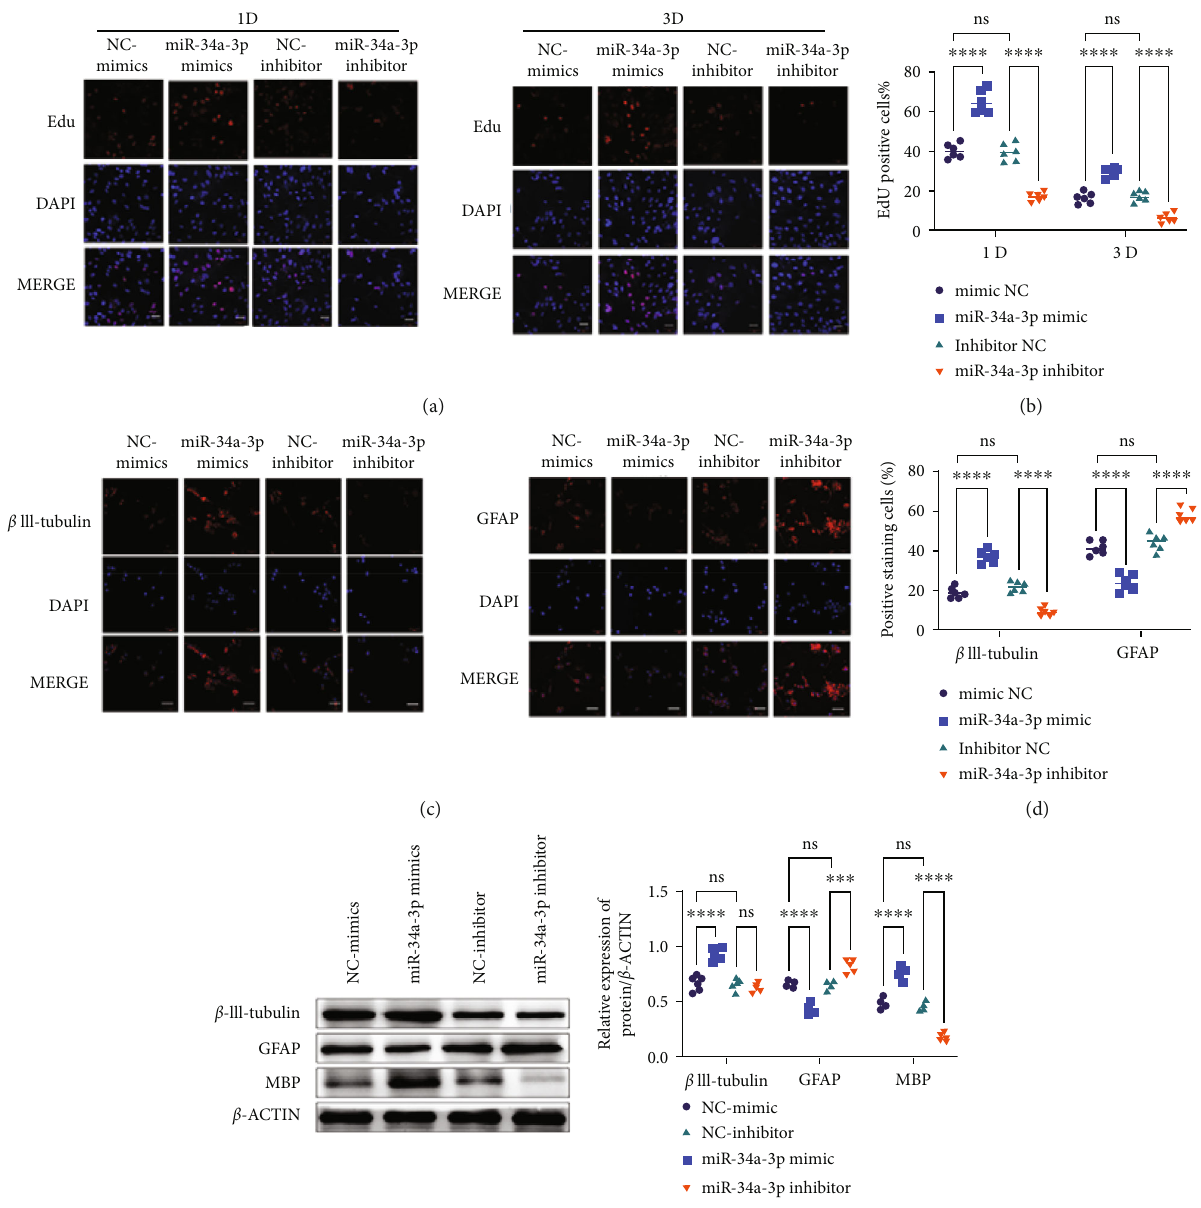
Figure 2: miR-34a-3p facilitates in vitro NSC proliferation/neuronal di ff erentiation. (a) EdU cell proliferation assay of NSCs at di ff erent time points after treatment with miR-34a-3p mimic or inhibitor. Representative images of six ( n = 6 ) independent experiments are presented. (b) Quanti fi cation of EdU-positive NSCs. (c) Immuno fl uorescence analysis of β III-tubulin and GFAP in di ff erent treatment groups. Representative images of six ( n = 6 ) independent experiments were presented. (d) Quantitative representation of β III-tubulin- and GFAP-positive cells in di ff erent treatment groups as obtained from immuno fl uorescence analysis. (e, f) Western blot analyses and quanti fi cation of 3 important markers of neuronal di ff erentiation (MBP, β III-tubulin and GFAP). Representative images of six ( n = 6 ) independent experiments were presented. For the EdU, immuno fl uorescence, and western blotting experiments, two-way ANOVA followed by the Š ídák ’ s multiple comparisons test were utilized to identify di ff erences. ∗ p < 0 : 05 , ∗∗ p < 0 : 01 , ∗∗∗ p < 0 : 001 , ∗∗∗∗ p < 0 : 0001 , and ns: nonsigni fi cant among the compared groups. Scale bars = 20 μ m